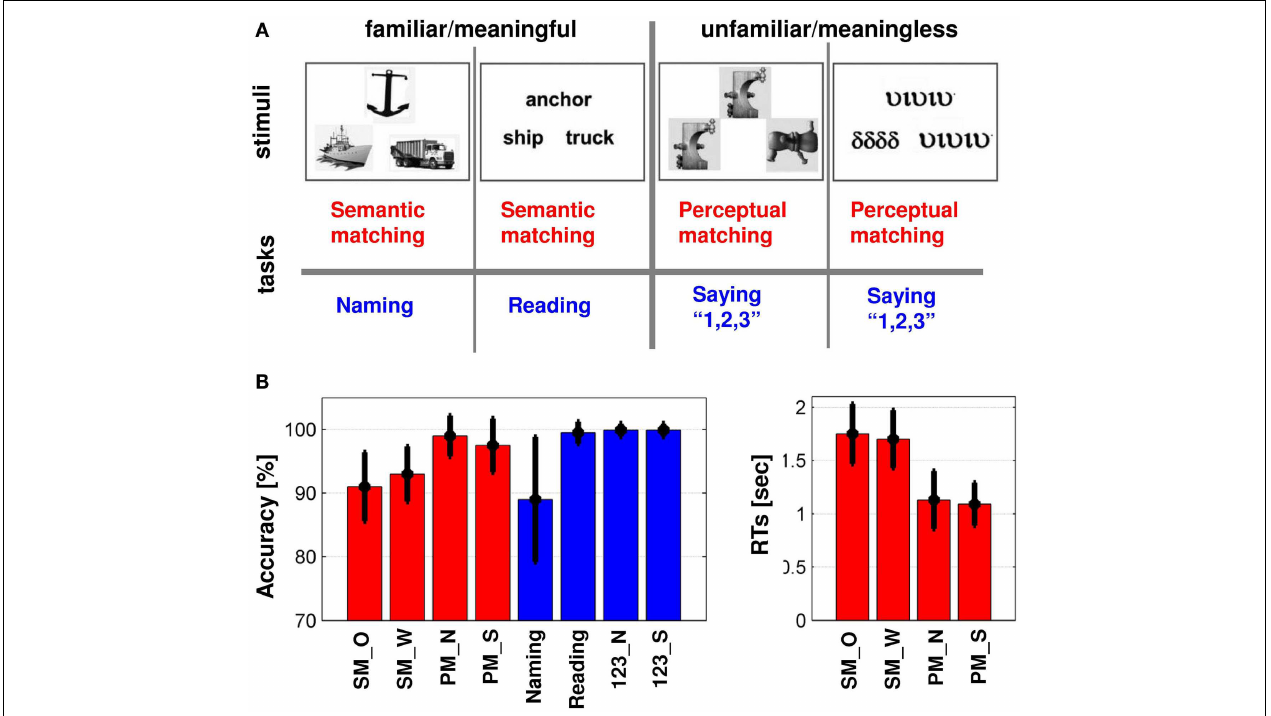
times [RTs in (s)] during all conditions over our 94 subjects. All subjects performed the tasks with high accuracy. SM_O, semantic matching on objects; SM_W, semantic matching on words; PM_N, perceptual matching on non-objects; PM_S, perceptual matching on symbols; 123_N, say “1,2,3” to non-objects; 123_S, say “1,2,3” to